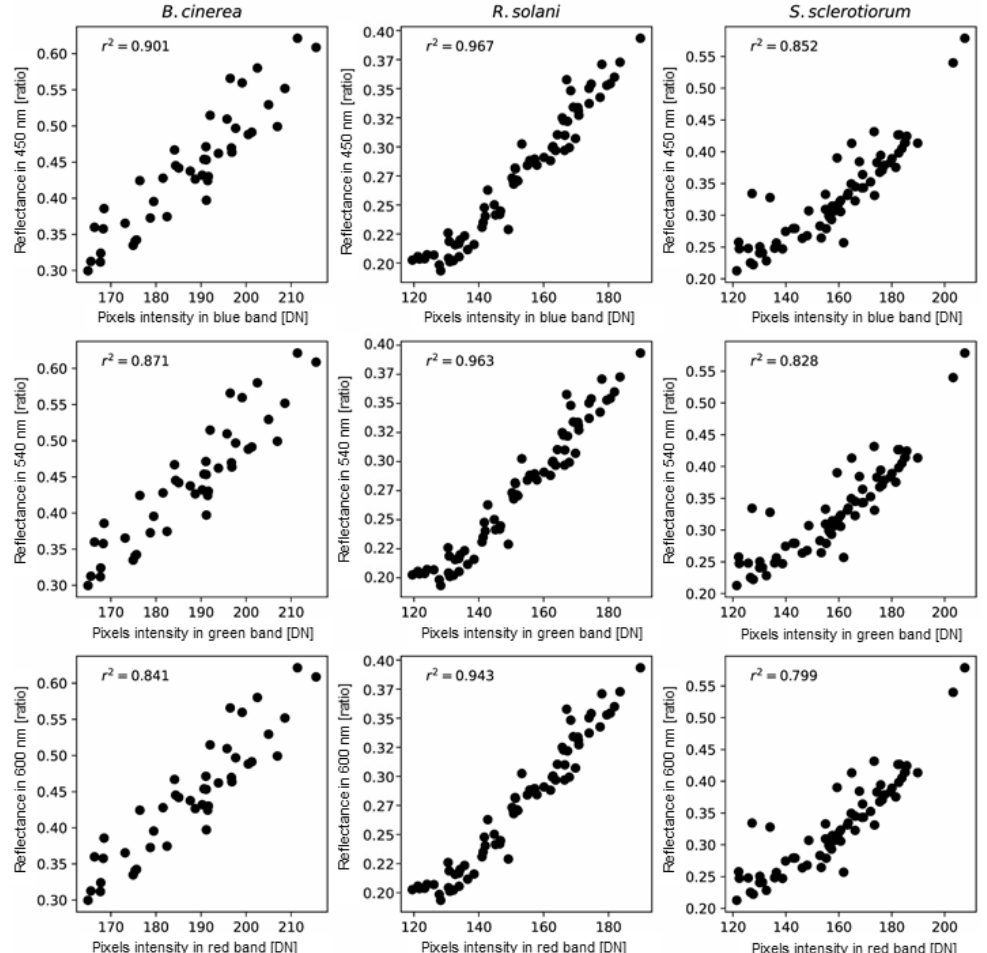
Figure 6. Relationships between the reflectance of the three wavelengths 450, 540, 600 nm and the average intensity of the pixels from the three RGB channels (red, green, blue) ( p -value for all r 2 < 10 −1 6 ).